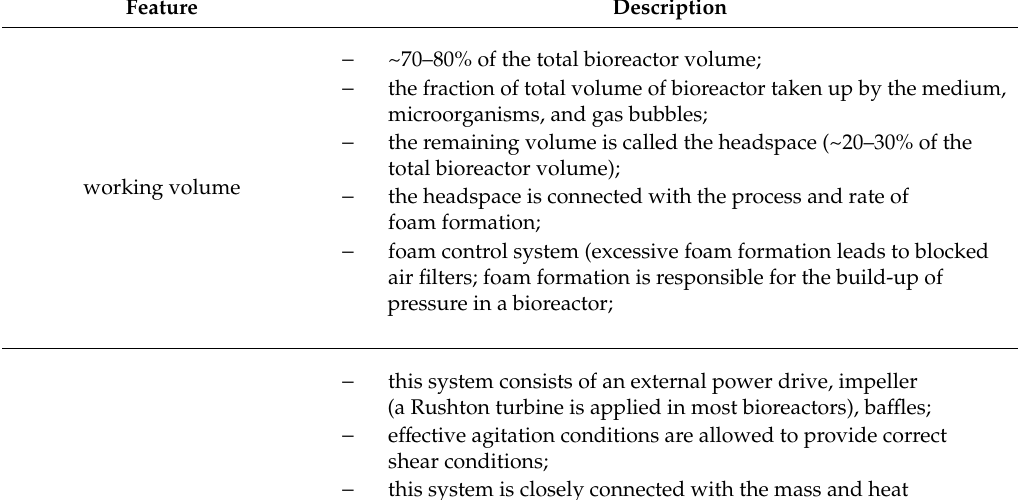
Table 1. The basic features of a